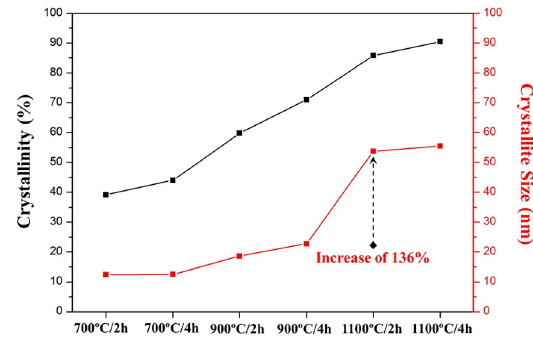
O powders. Figure 4. Effect of temperature and time of calcination on crystallinity 2 4